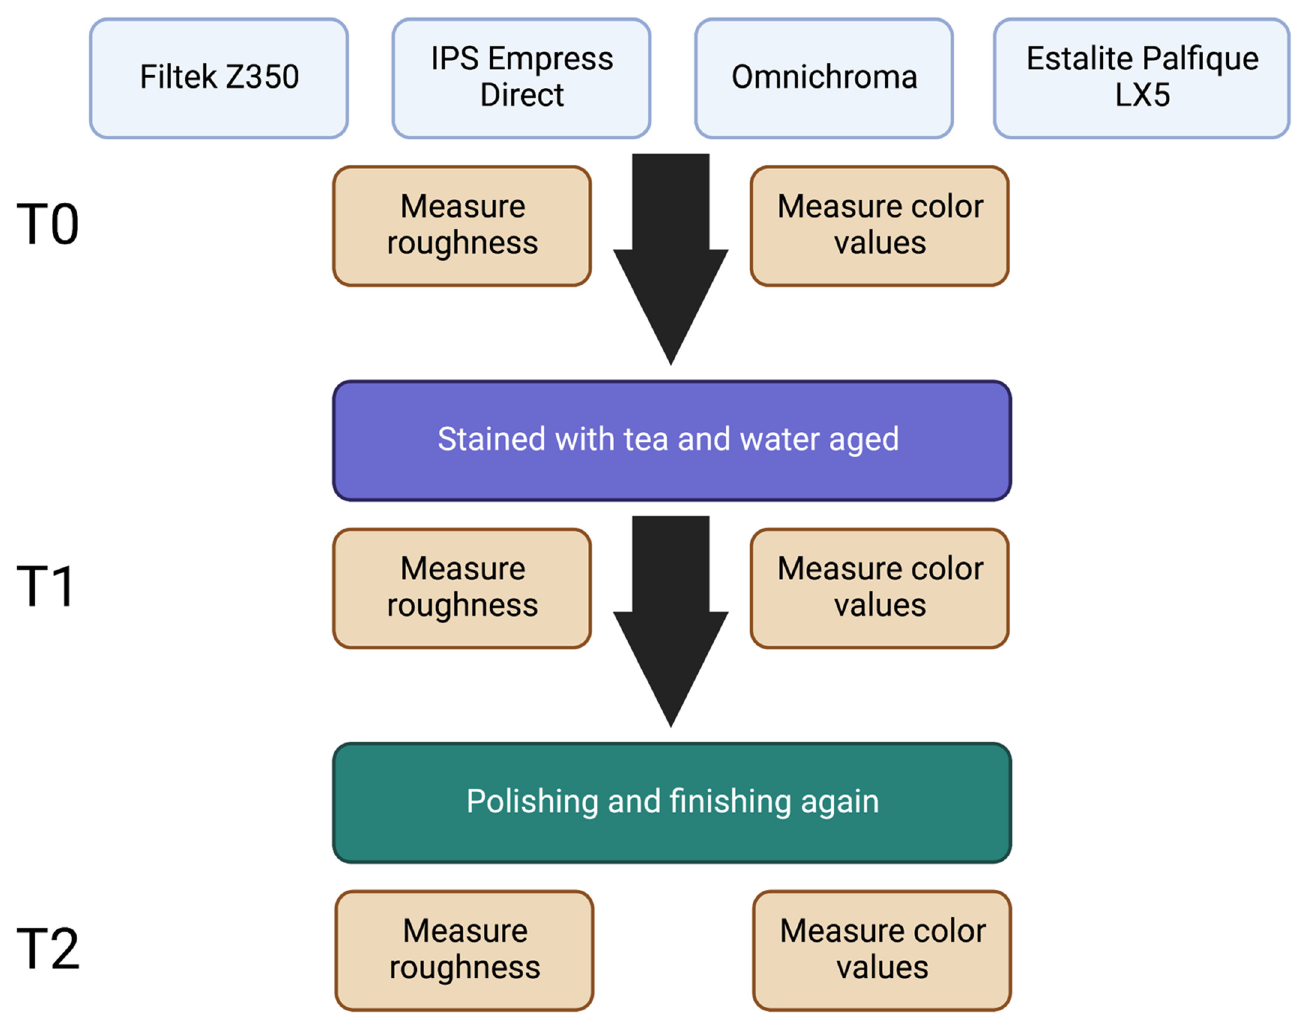
Figure 1. Overall study design. Diagram created with Biorender.com. Table 2. Color-change parameters for resin composites at baseline (T0), after staining (T1), and after polishing (T2).